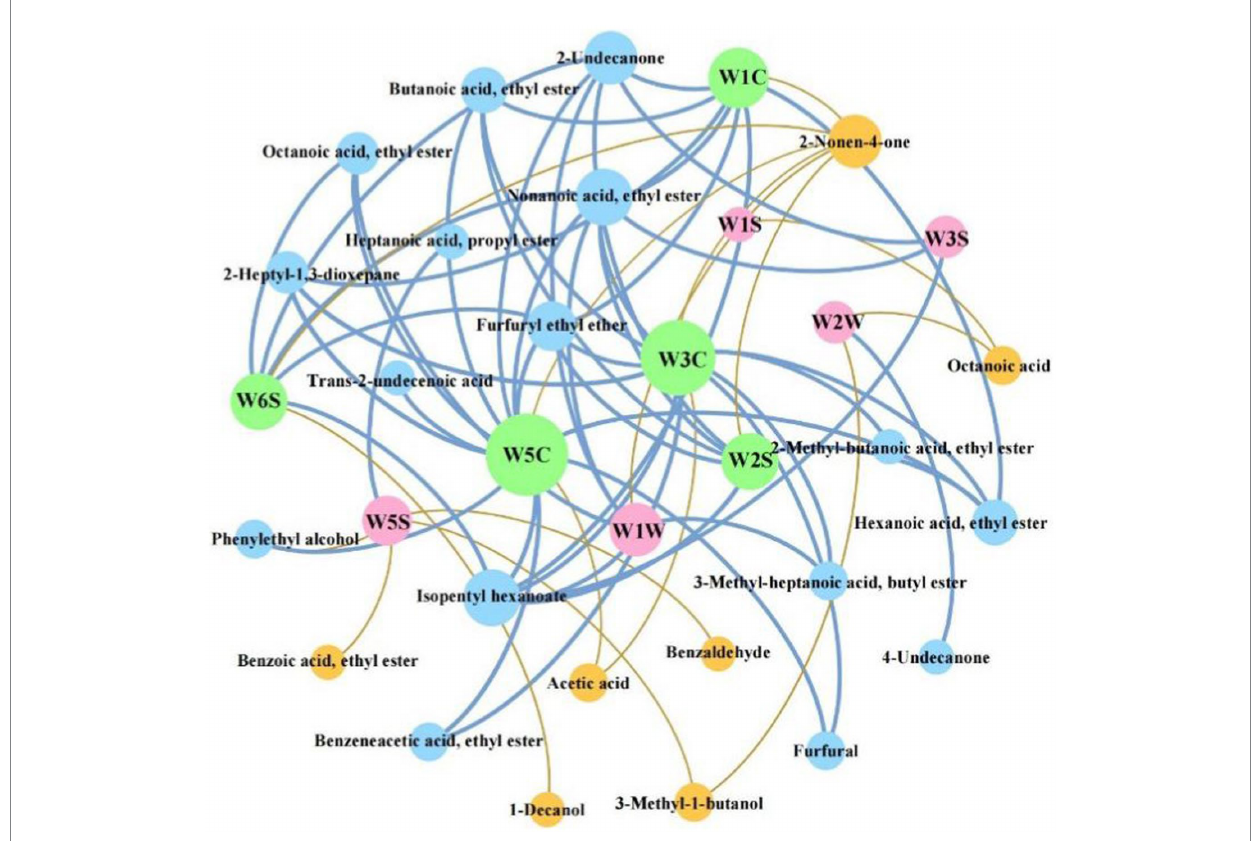
FIGURE 9 Correlation analysis of differential compounds and sensors responses of electronic nose (E-nose).